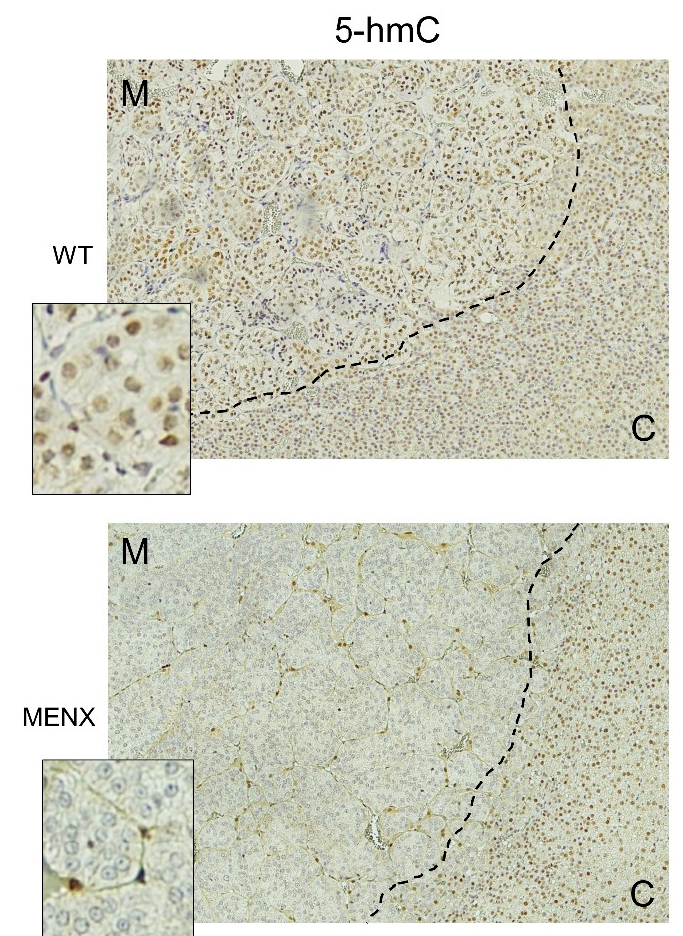
Figure 4. IHC of the epigenetic marker 5-hmC in MENX PCCs. IHC staining for 5-hmC of a wildtype adrenal medulla (WT) and a representative MENX adv. PCC (n = 10) at 7–9 months of age. Sustentacular cells and adjacent cortical cells remain 5-hmC positive, which is lost in the tumor cells. Magnification: 100 × , inset = 300 × , M = medulla, C =